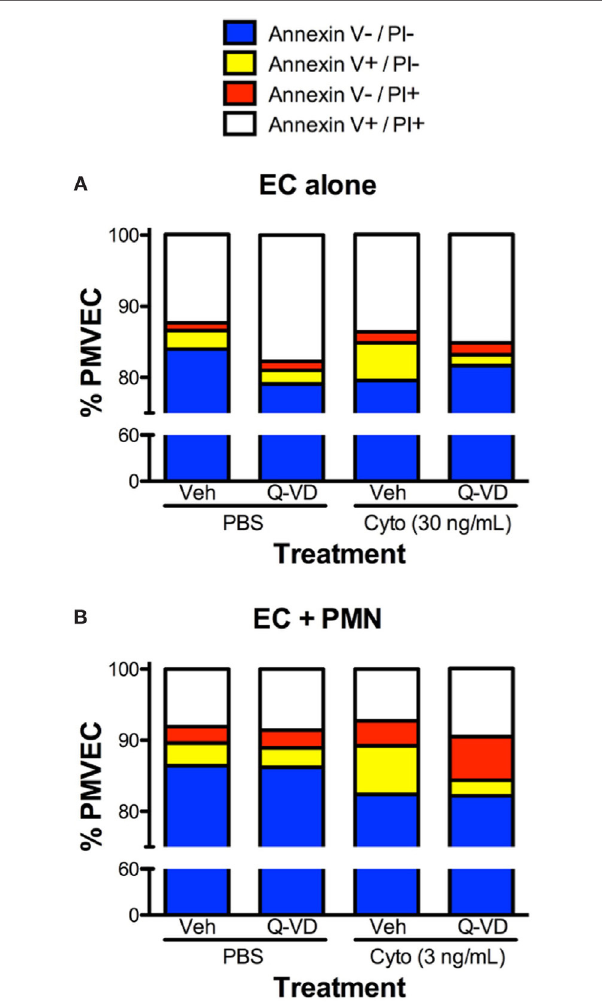
FigUre 8 | Effects of cytomix treatment of human PMVEC on different types of cell death. (a) Cytomix (30 ng/mL) treatment increased Annexin V + / propidium iodide (PI) − PMVEC (yellow bar; suggestive of early apoptosis), but had no effect on PI staining, including specifically both Annexin V − /PI + cells (red bar; indicative of pyroptosis) and Annexin V + /PI + cells (white bar; later stage apoptosis and necrosis/necroptosis). The cytomix-induced increase in Annexin V staining was completely abrogated by Q-VD treatment. (B) Similarly, in PMN–PMVEC cocultures, cytomix treatment (3 ng/mL) increased Annexin V + /PI − PMVEC (yellow bar) and was not associated with any significant change in Annexin V − /PI + (red bar) and Annexin V + /PI + (white bar) PMVEC vs. PBS. The cytomix-induced increase in Annexin V + /PI − PMVEC was completely inhibited by Q-VD treatment. Complete data and variance are provided in Table 1